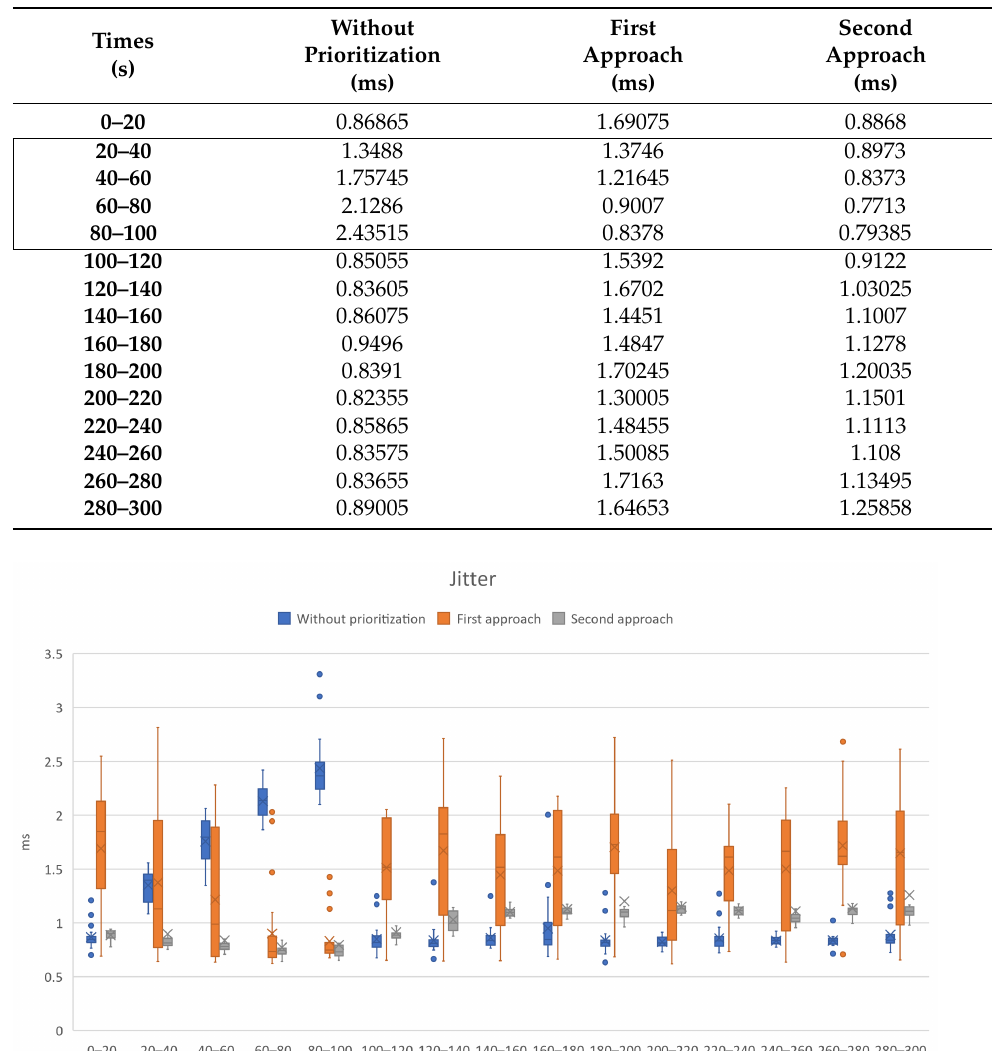
Table 7. Mean jitter values measured in each scenario in the Control slice.